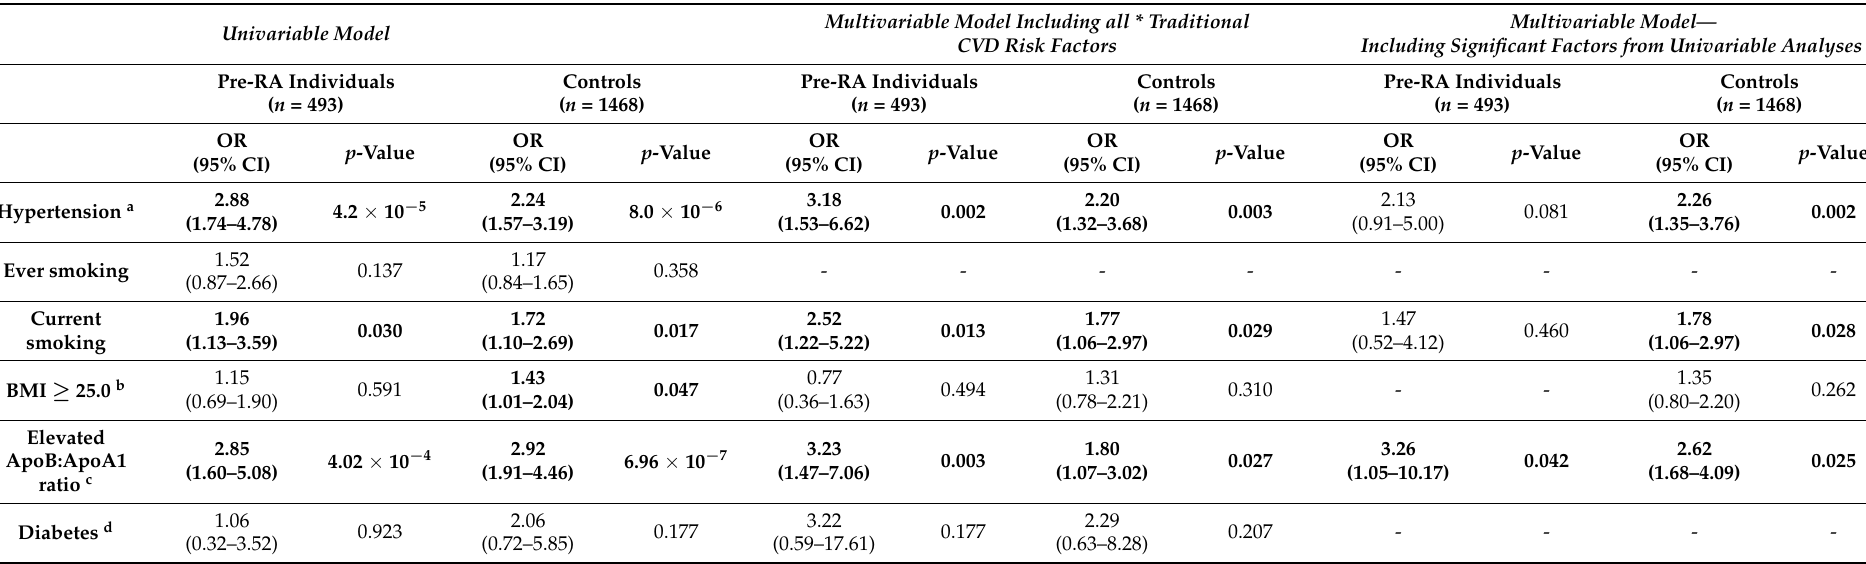
Table 3. Association of risk factors for cardiovascular disease with cardiovascular events in pre-RA and control